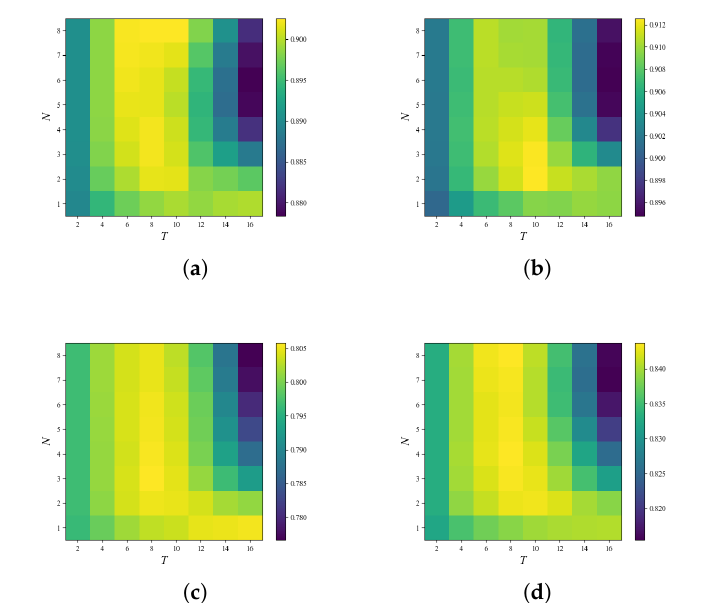
Figure 12. OA of the FloodNet images using different sets of parameters: ( a ) SVM + MCLU + SNSSL on 6651; ( b ) XGB + BT + SNSSL on 6651; ( c ) SVM + MCLU + SNSSL on 7577; ( d ) XGB + BT + SNSSL on 7577.